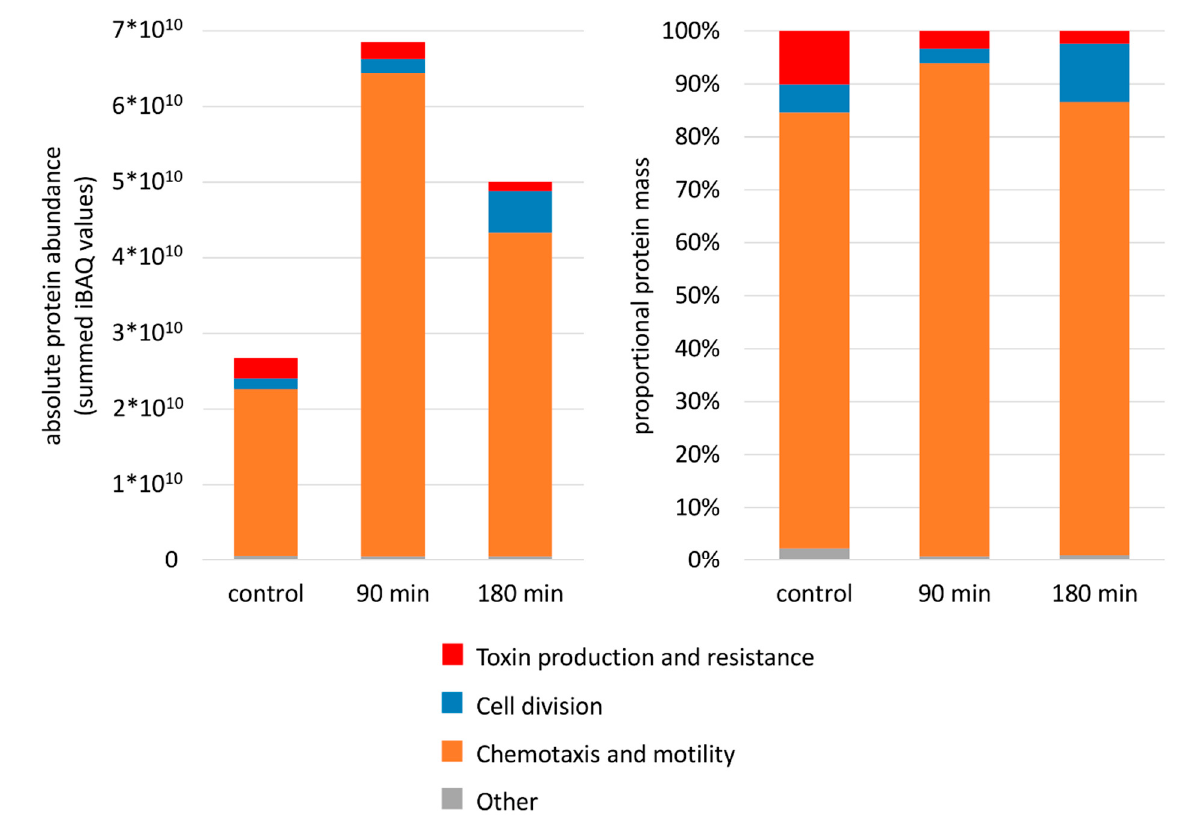
Figure 6. Changes in abundance of proteins involved in cellular processes (according to TIGRFams) after nisin treatment. The fraction of proteins assigned to this functional category was calculated by summing up iBAQ intensities for those proteins quantified in the membrane fraction at the respective sampling point. The figure compares the absolute protein amount provided as summed iBAQ values ( left ) to the proportional mass given in percent ( right ).